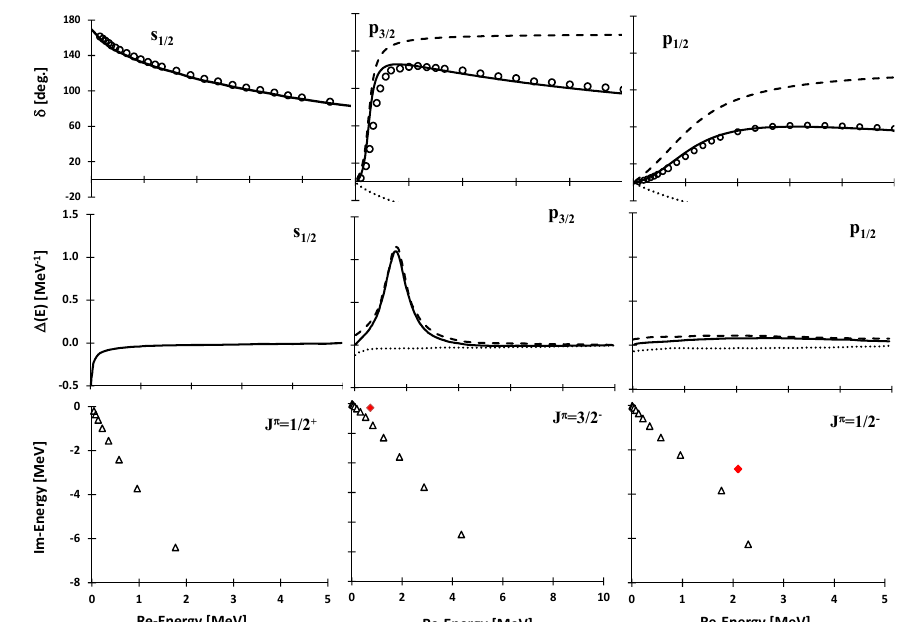
n ( 5 He) system for the J π = 1 / 2 + , 3 / 2 − , 1 / 2 − states and Figure 1. Upper panel: the decomposition of scattering phase shifts of α − middle panel: the decomposition of continuum level densities. The dashed and dotted lines represent the contributions of resonance and continuum terms, respectively. The solid lines display total scattering phase shifts or total continuum level densities. Lower panel: the distributions of eigenvalues are displayed in the complex energy plane. The diamond displays the resonance pole. The experimental data [6] are shown with open circles.